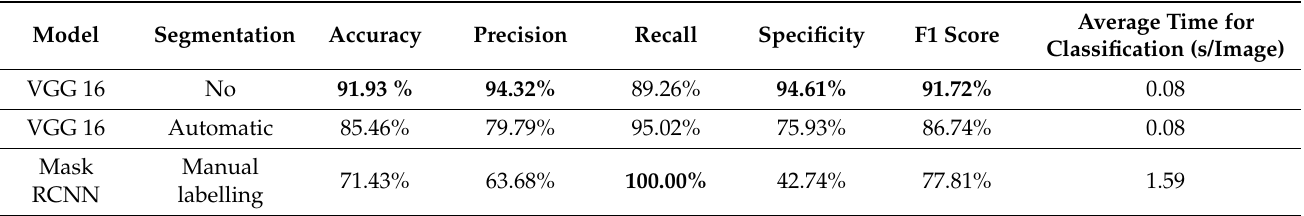
Table 4. The performance of the BSR detection models using images extracted from 938 nm wave- length in all